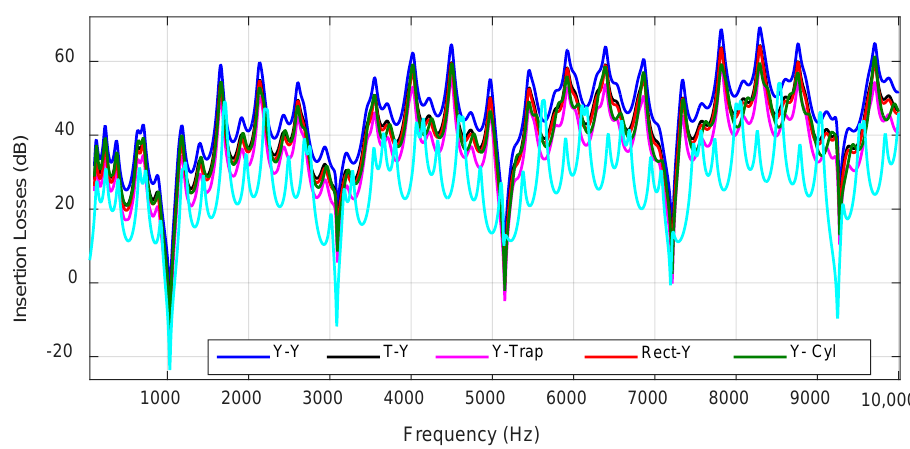
Figure 16. IL for Configuration 1 (‘Car–Person’) considering double caps formed with Y-shaped structures and a single screen barrier as a reference.